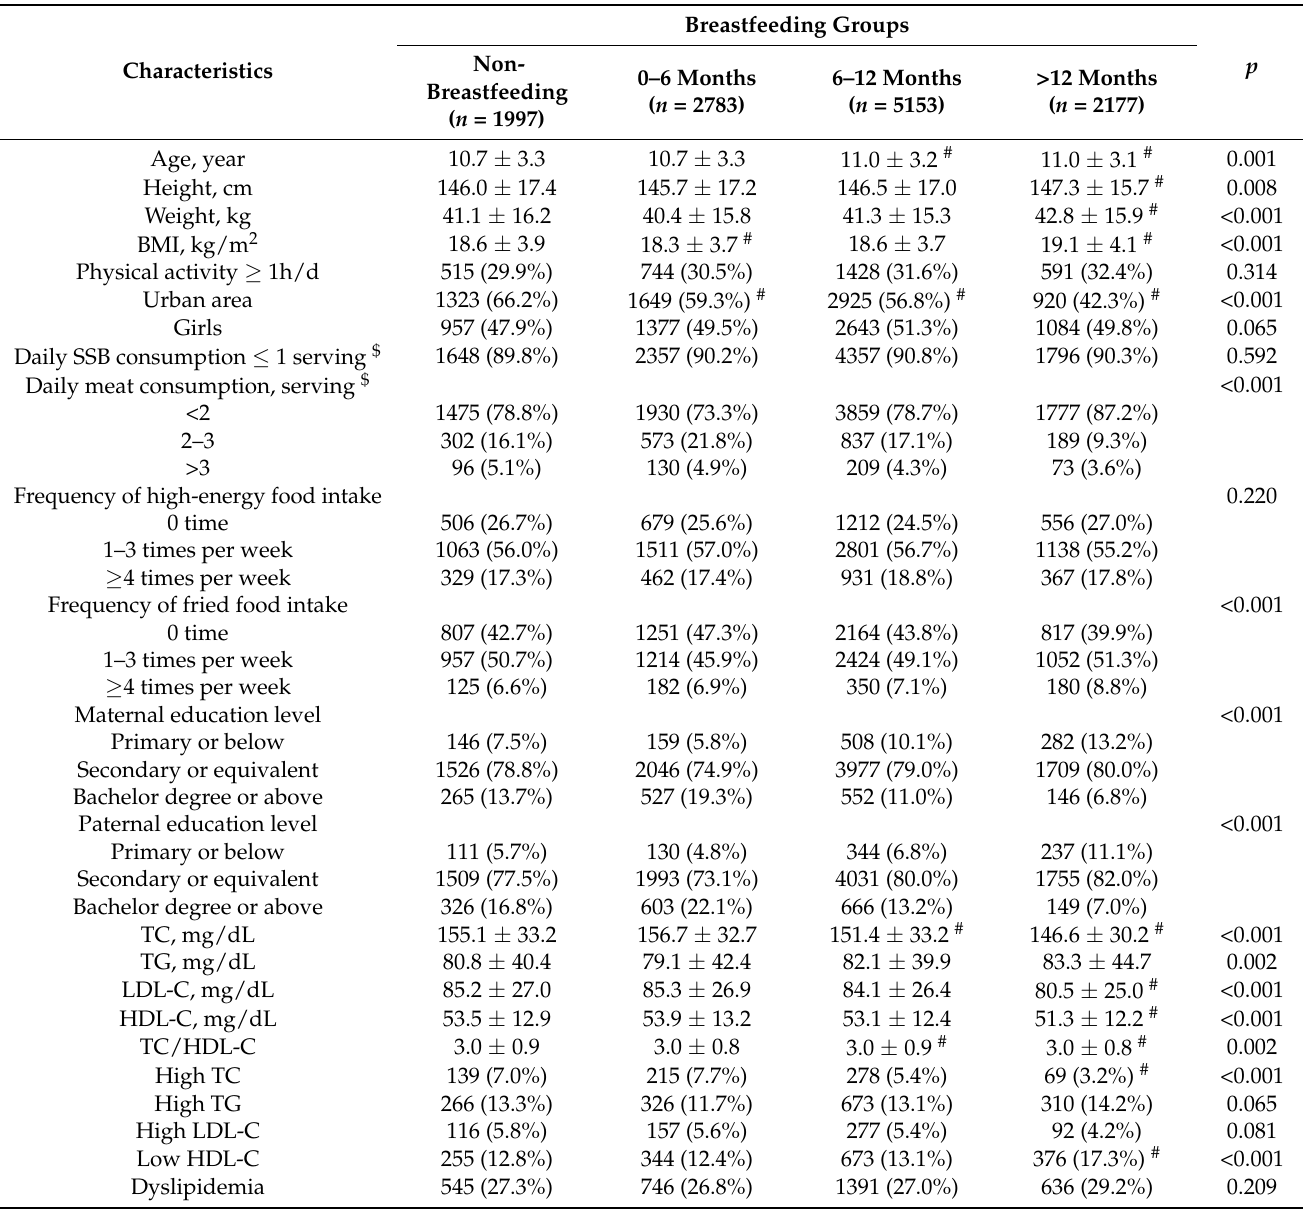
Table 1. Characteristics of participants by different breastfeeding